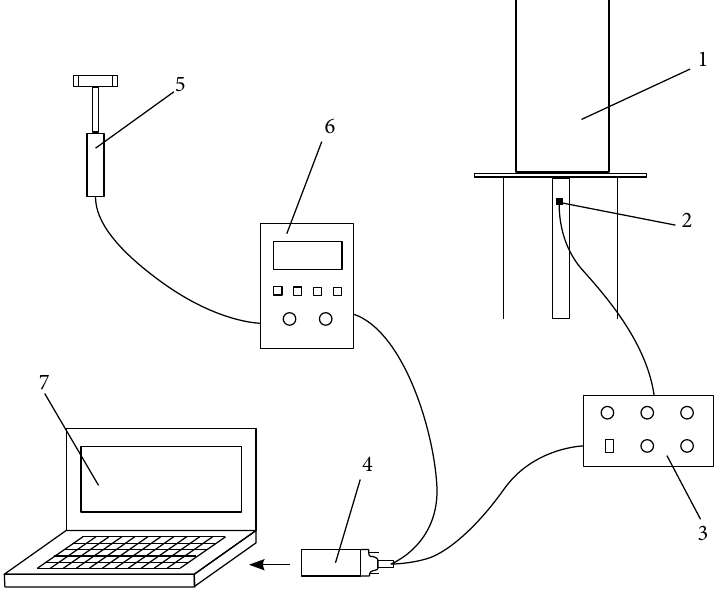
Figure 4. Experimental set for modal analysis.